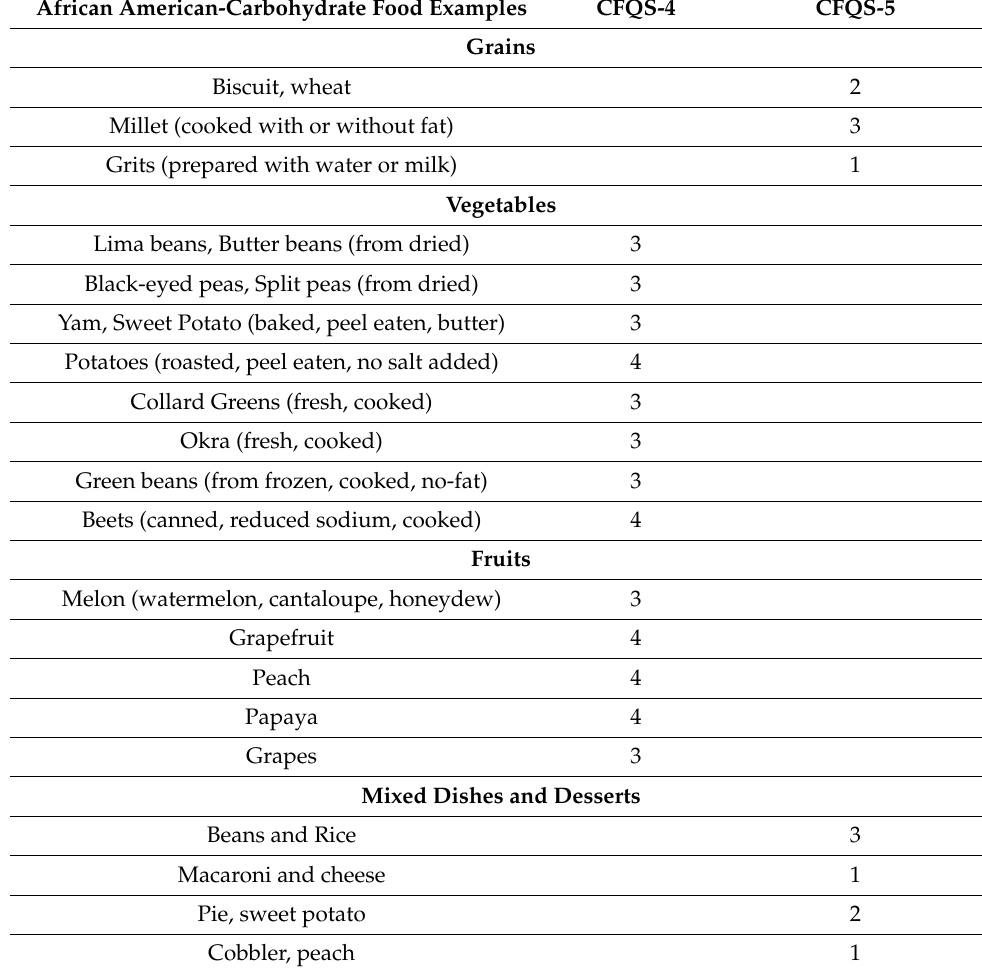
Table 3. CFQS Models Applied to African American Culturally Inclusive Dietary Patterns. African American-Carbohydrate Food Examples